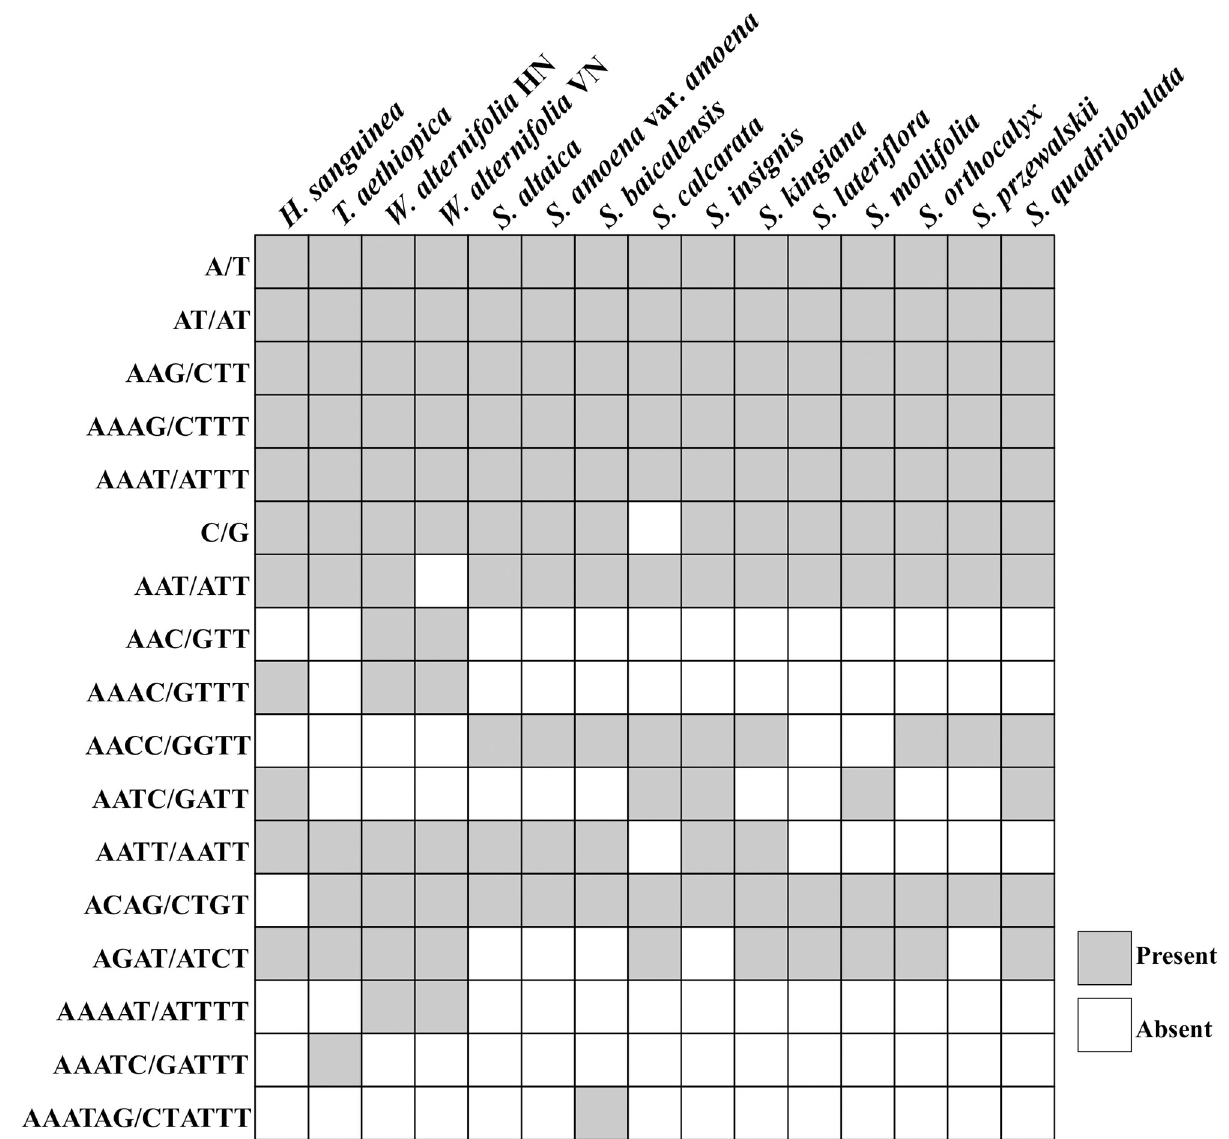
Fig 3. Distribution of the 17 types of SSR repeat units among 15 plastomes of Scutellarioideae and their relationships. The horizontal axis indicates the species name and the Y-scale indicates the type of repeat unit.